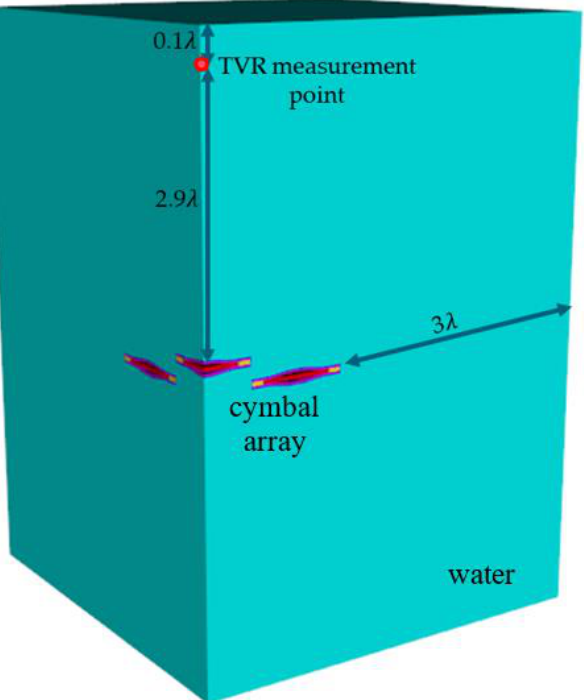
Figure 3. Finite element model of the immersed 3 × 3 cymbal array.